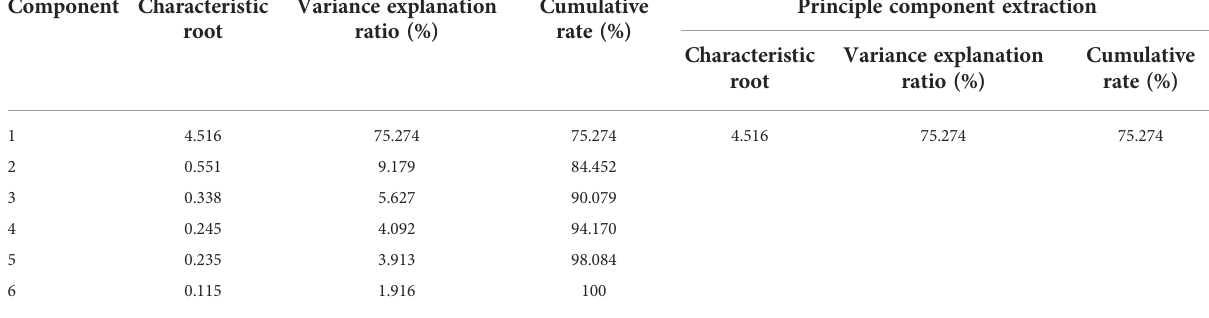
TABLE 5 The result of PCA.